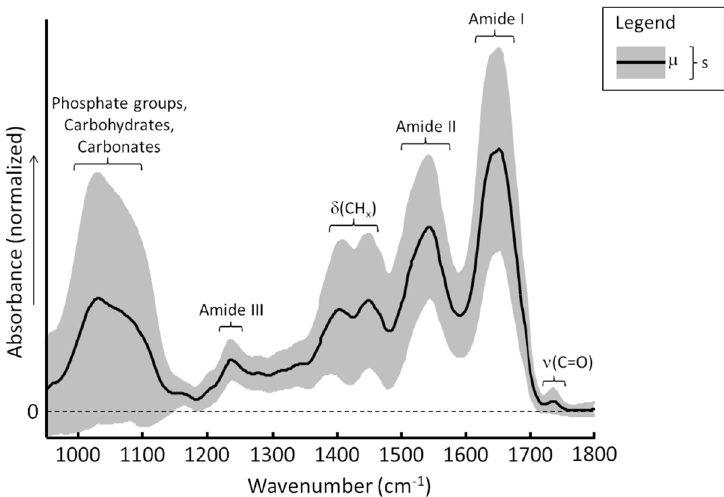
Figure 2. Mean FT-IR-spectrum (bold) and standard deviation (grey) calculated from the spectroscopic imaging data set of the human AV sample (see Figure 1). The most intense and prominent absorptions are assigned to proteins and to mineralized species.